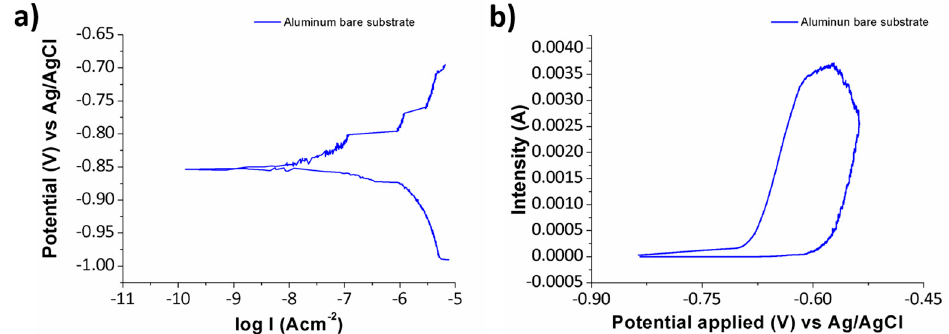
Figure 8. Tafel plot ( a ) and pitting corrosion curve ( b ) for the reference aluminum bare substrate in 3.5 wt % NaCl aqueous solution.